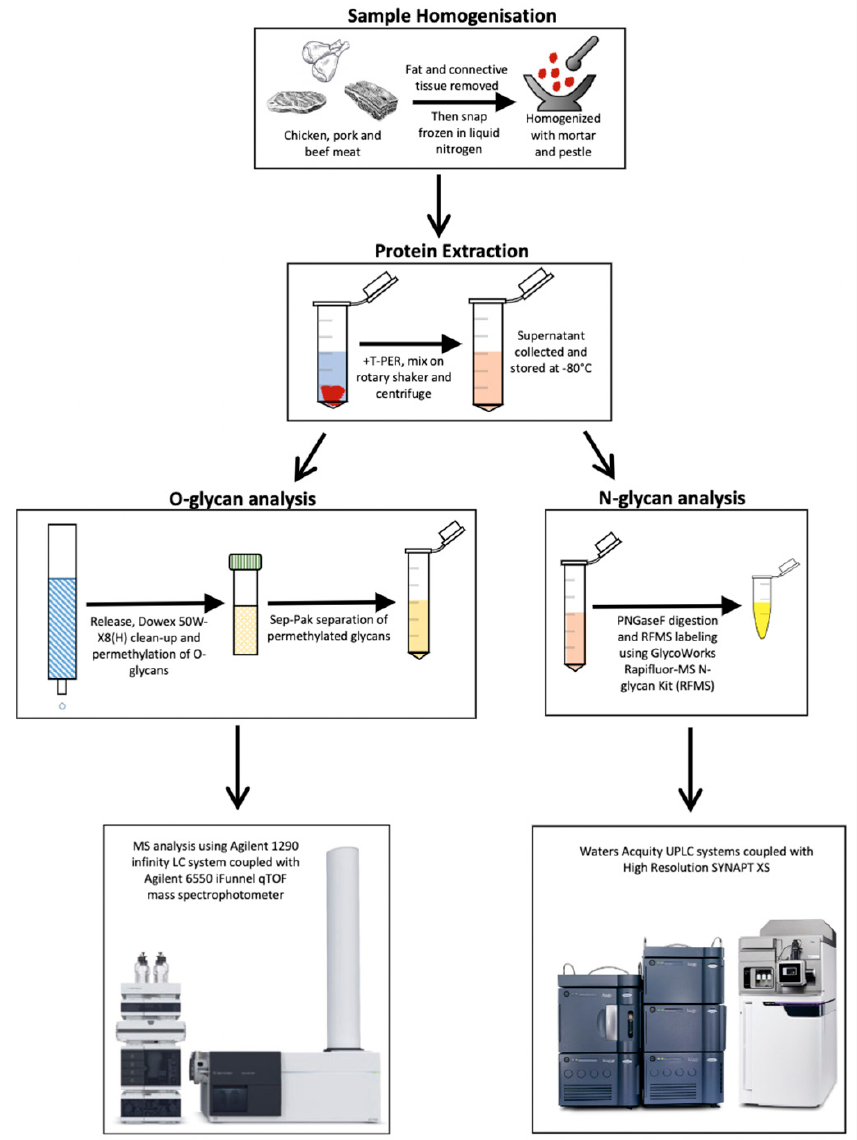
Figure 1. Glycomics-based workflow for the characterisation and profiling of meat samples. Samples are first processed for the extraction of proteins, which undergo separate procedures for the release of N-linked and O-linked glycans. These glycans are finally quantitated via a mass spectrometry-based analysis. Permethylated O-glycans are quantitated through the mass abundance of the ions whilst N-glycans are quantitated via the fluorescence of the RFMS label.